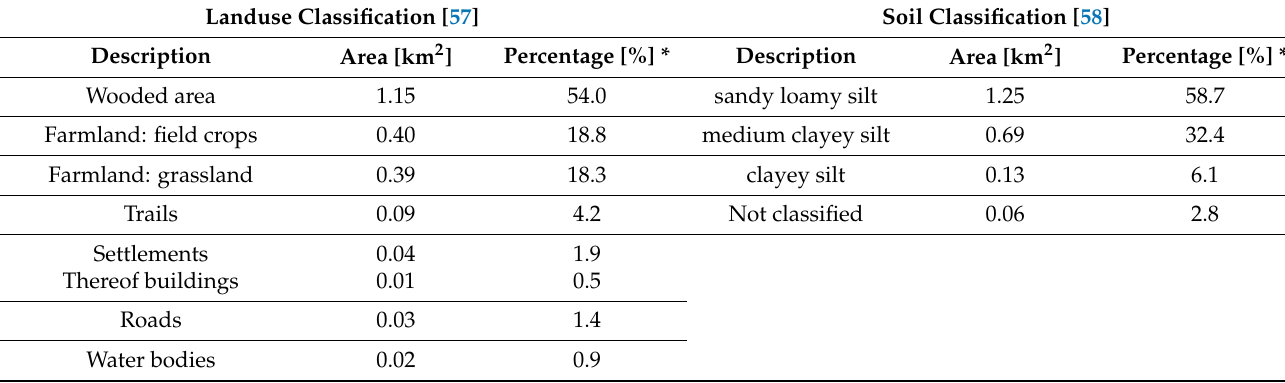
Figure 3. Topography of the Messbach catchment and location of Messbach village [56]. Table 4. Summary of landuse [57] and soil [58] in the Messbach